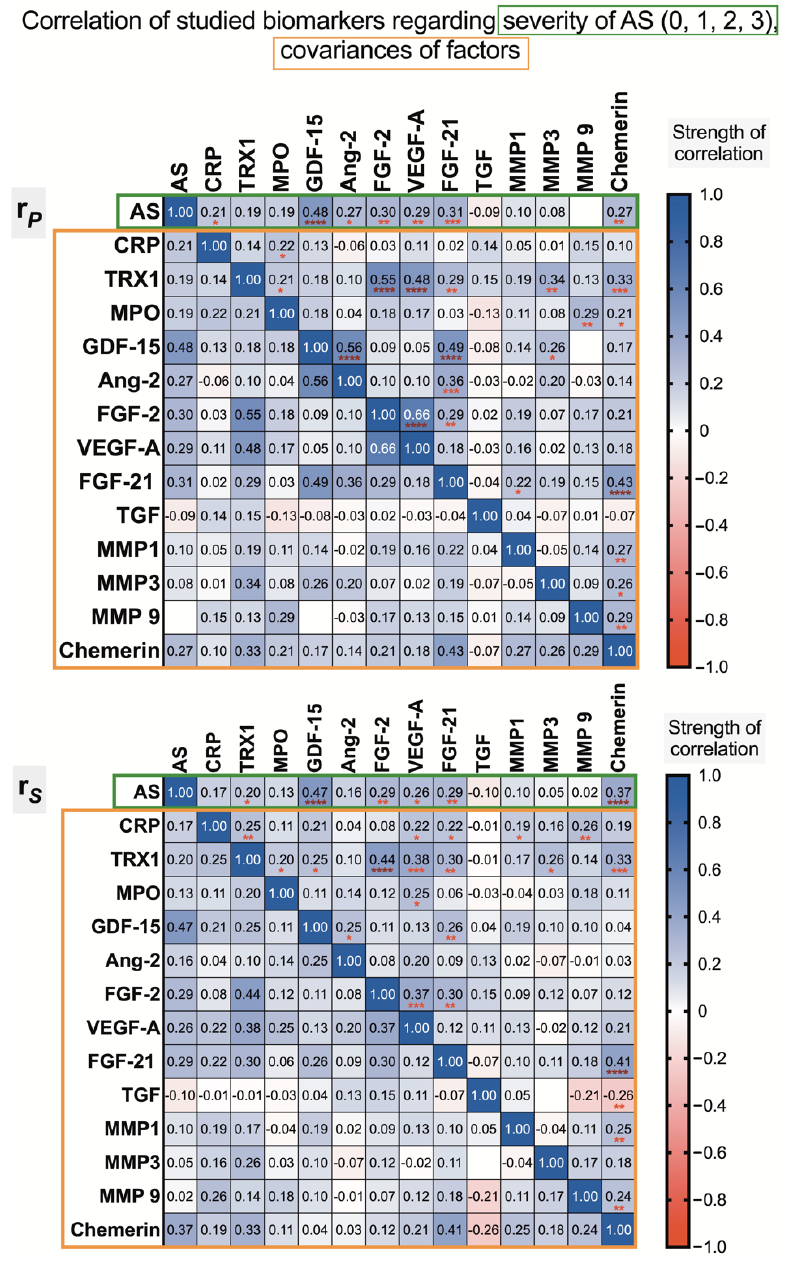
Figure 7. Corelation of studied biomarkers regarding severity of AS (0—no (control), 1—mild, 2—moderate, 3—severe; closeness of associative relations is characterized by p -value—* p < 0.05, ** p < 0.01, *** p < 0.001, **** p < 0.0001; green frame); covariances of studied biomarkers (orange frame); r P —Pearson’s correlation coefficients, r S —Spearman’s rank correlation coefficients.